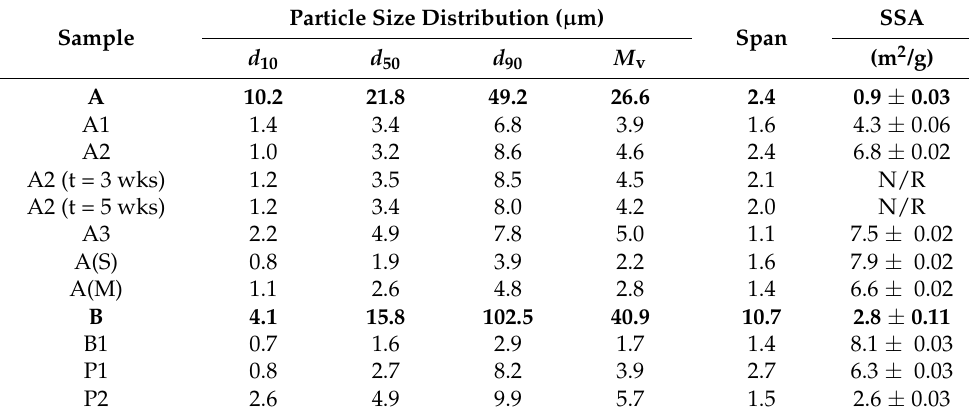
Table 1. Particle size distributions, specific surface area (SSA), and descriptions of Odanacatib samples.